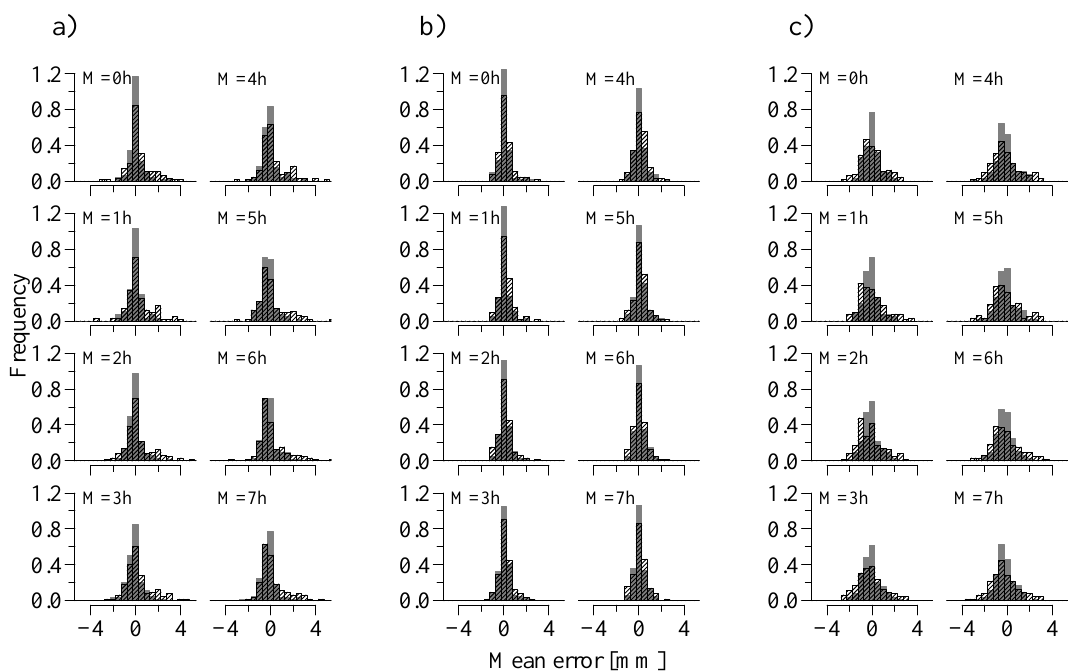
Fig. 15. Validation for three real-world events for simulation memories ranging from 0 to 7h: (a) 22 October 2002, (b) 22 December 2002 and (c) 1 January 2003. Histograms of the validation mean errors at 13 rain gauges (dashed histograms). Histograms of the simulation mean errors for the same 13 rain gauges (grey histograms).